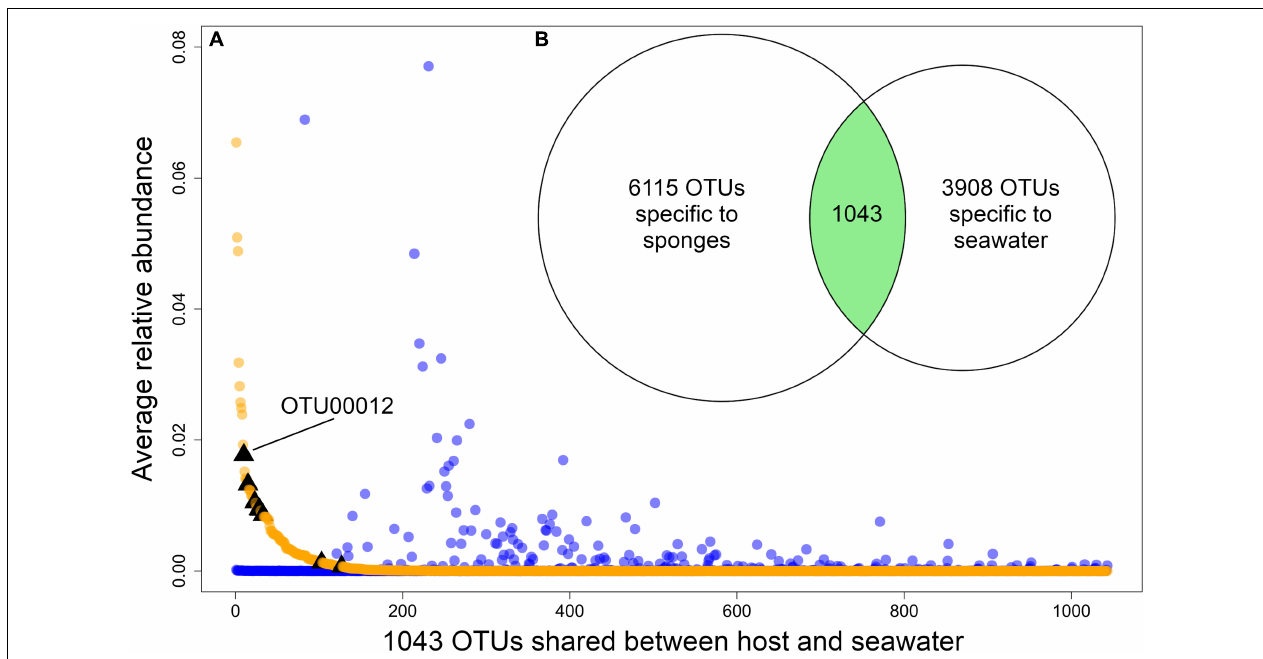
FIGURE 2 | (A) Plot showing the relative abundances of the 1043 OTUs that are shared between sponges and seawater, restricted to Panama and Belize. Orange dots are relative abundances in sponges, blue dots are relative abundances in seawater. Black triangles mark OTUs that correspond to vertically transmitted bacteria in I. felix (Schmitt et al., 2007). (B) Venn diagram showing the number of sponge-specific OTUs, seawater-specific OTUs, and OTUs found in both sources. OTUs in the intersection of the two sources are plotted by relative abundance in (A)